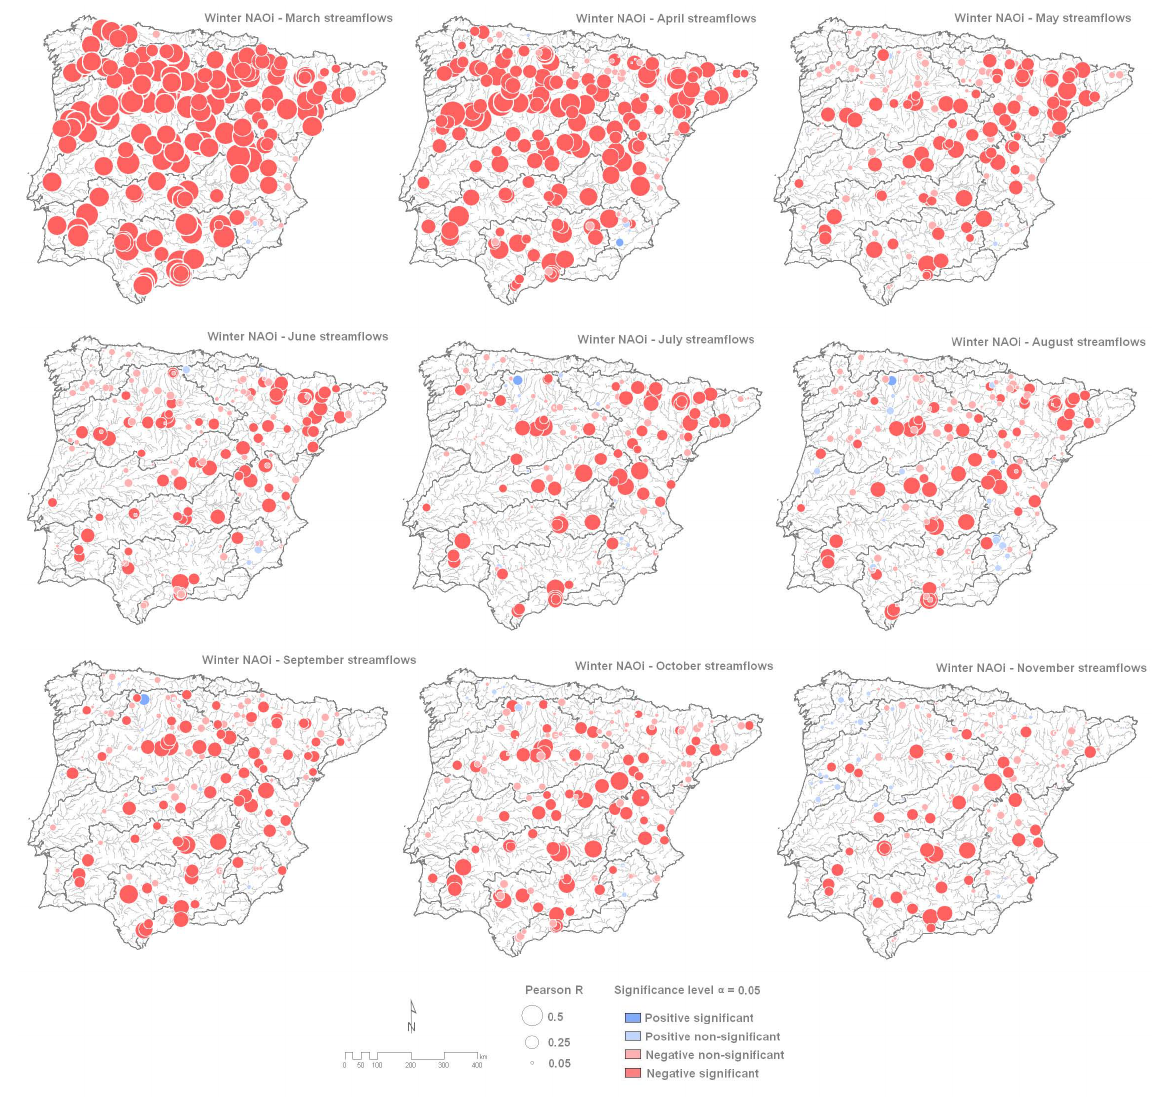
Fig. 4. Spatial distribution of the correlations between the Winter NAO index and the monthly